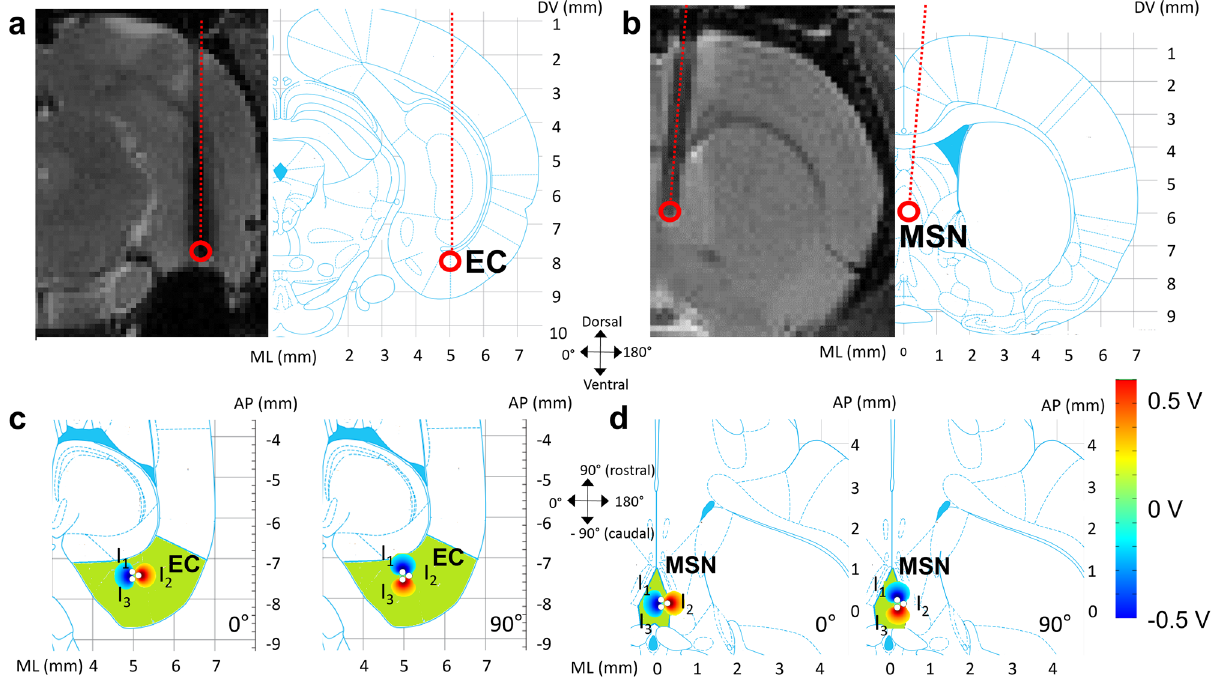
Figure 1. Electrode locations and electrical field distributions. Illustration of the electrode location in the EC ( a ) and MSN ( b ) on a coronal T2-weighted MRI image (left) and on a corresponding section (right) of the rat brain taken with permission from the Rat Brain in Stereotaxic Coordinates (6th Edition) atlas 36 . Schematics of the field distribution around the 3-channel electrode for two representative angles superimposed on an anatomical horizontal section (corresponding to an axial MRI view) of the rat brain taken from the atlas are shown for EC ( c ) and MSN ( d ) stimulation. Field distributions were obtained with COMSOL 5.4 (COMSOL, Stockholm, Sweden). 0°/180° corresponds to the mediolateral direction and 90°/− 90° corresponds to the rostrocaudal direction on the horizontal plane. The level of current and the diameter of the electrode bundle were set to 1 mA and ~ 350 µm, respectively, resembling the values that were used in the experiments. Brain images are displayed in neurological convention (left side of the image corresponds to the left side of the